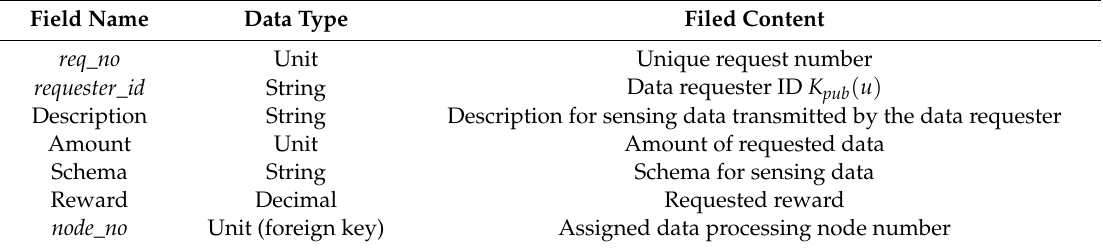
Table 5. Schema of request